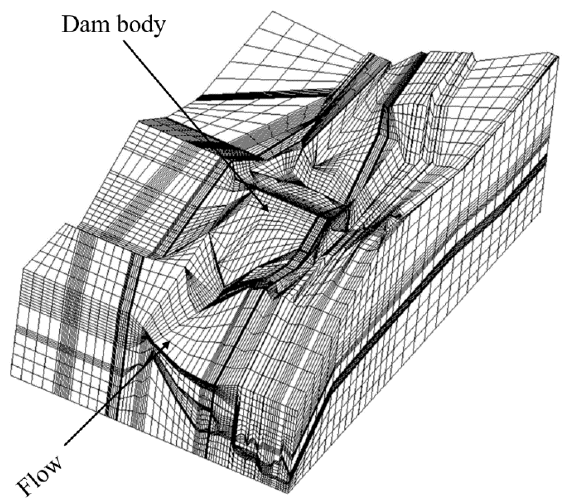
Figure 21. A 3D FEM model of the clay core dam.